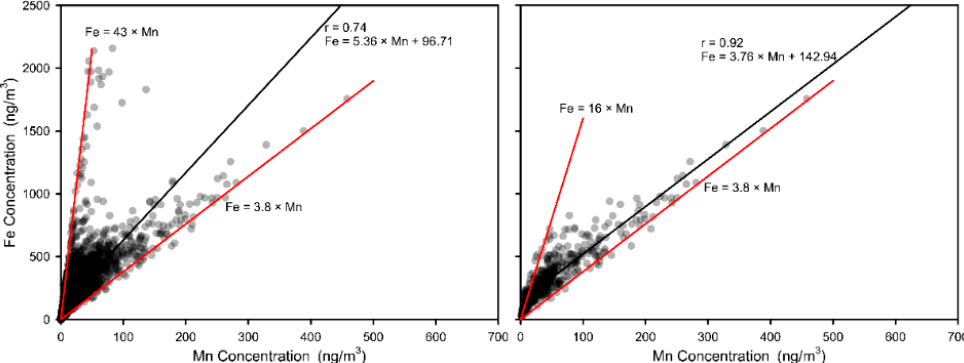
Figure 7. Correlations between iron (Fe) and manganese (Mn) in ALL ( left ) and SCs ( right